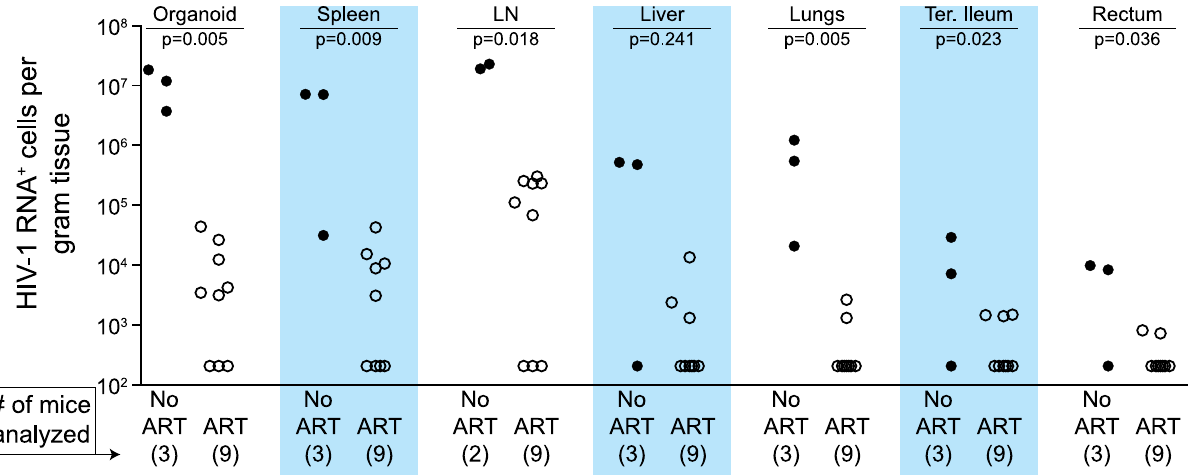
Figure 2. Durable reduction of the number of vRNA + cells occurs during ART. Quantitative ISH analysis reveals statistically significant reductions in the numbers of productively infected cells for each tissue obtained from animals undergoing antiretroviral therapy. Exact log rank tests were utilized to generate p values. When no RNA + cells were detected, then the number of RNA producing cells per gram tissue was set to 200 in the graph. (Closed symbols=no ART; open symbols=ART).